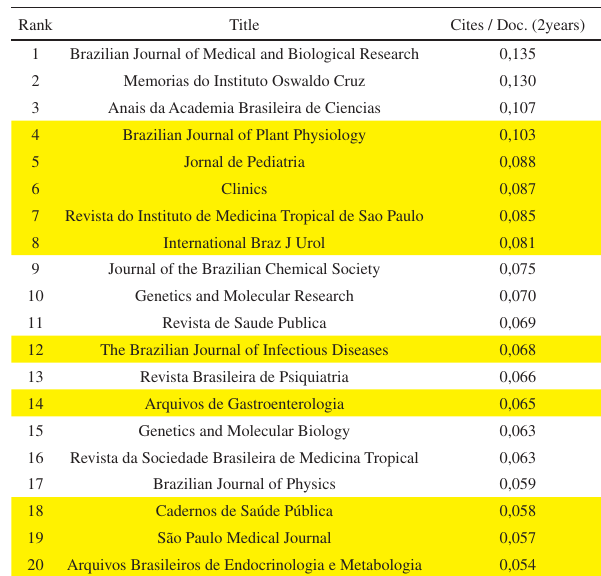
Table 2 - Top 20 (out of 153) Brazilian Journals in the Sci- mago Journal Ranking. Highlighted in yellow are Journals excluded from ISI -